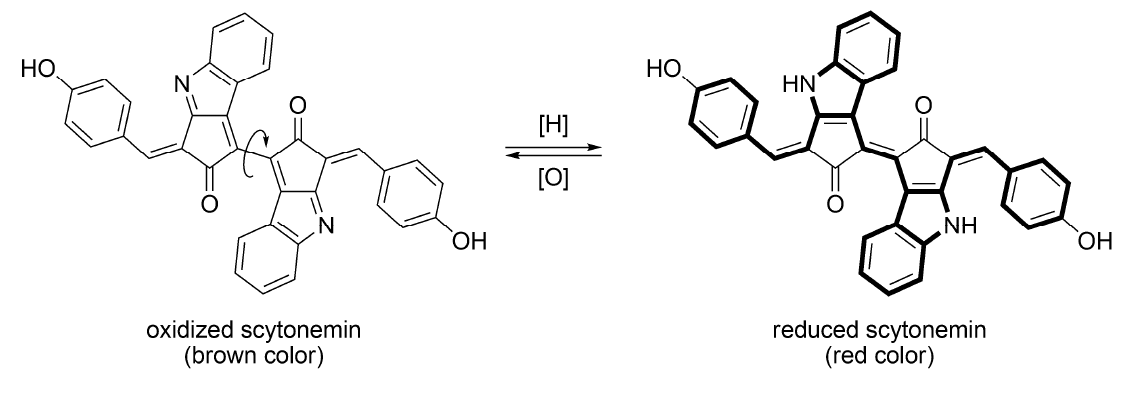
Figure 6. Structures of oxidized and reduced scytonemin. The  -conjugation in reduced scytonemin is drawn in a bold